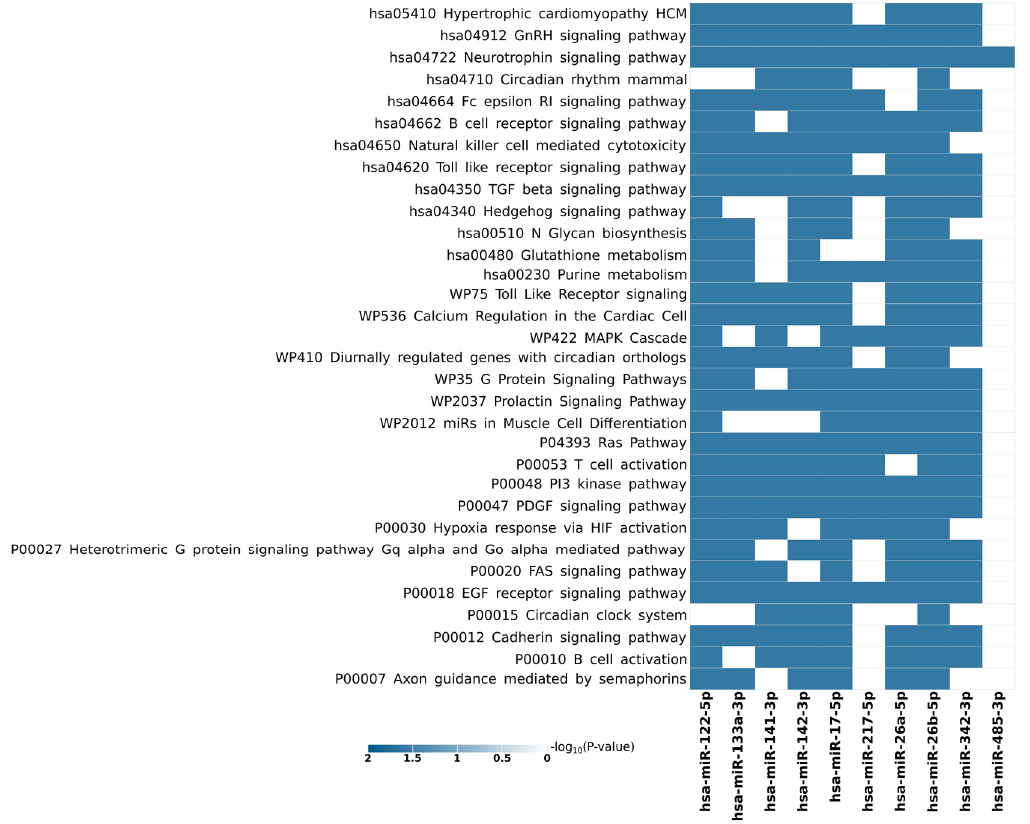
Figure 5. Exosomal lncRNA/circRNA-sponged miRNAs functional enrichment analysis via miEAA. Thirty-two pathways were found to be significantly enriched by our list of 15 literature-curated miRNAs in the exosomal lncRNA/circRNA–miRNA–target axis. p value threshold = 0.025. FDR (Benjamini–Hochberg) p value adjustment. Minimum required hits per subcategory = 2.